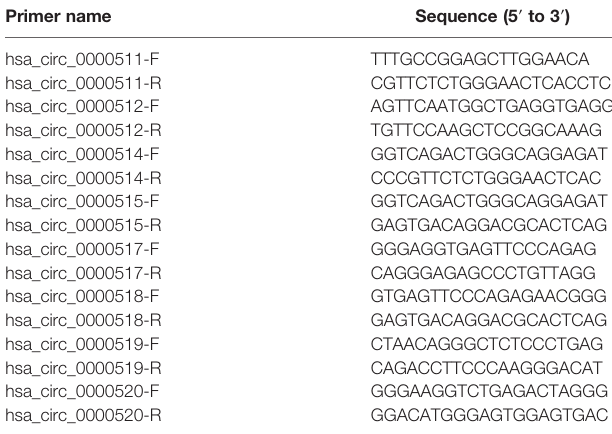
TABLE 1 | Primers for circular RNA (circRNA) ampli fi